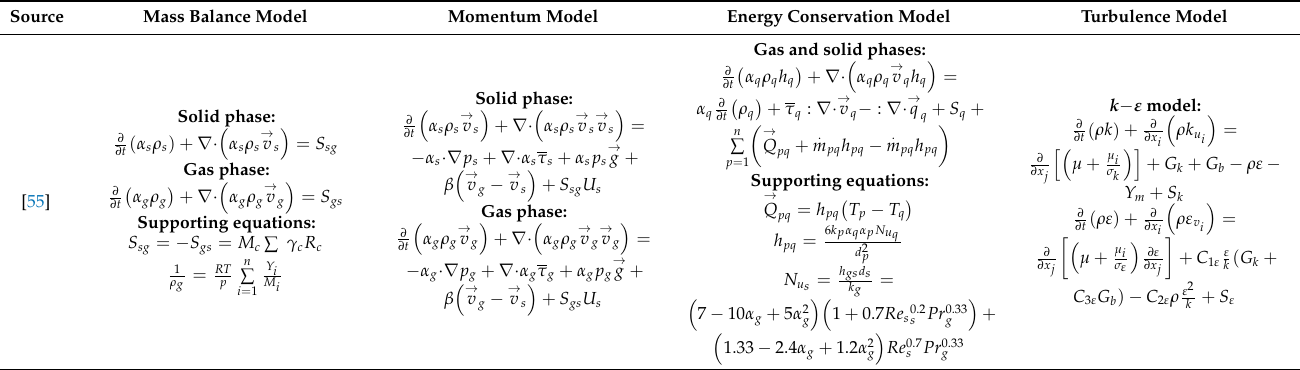
Table 7. Governing equations within a plasma gasification reactor.